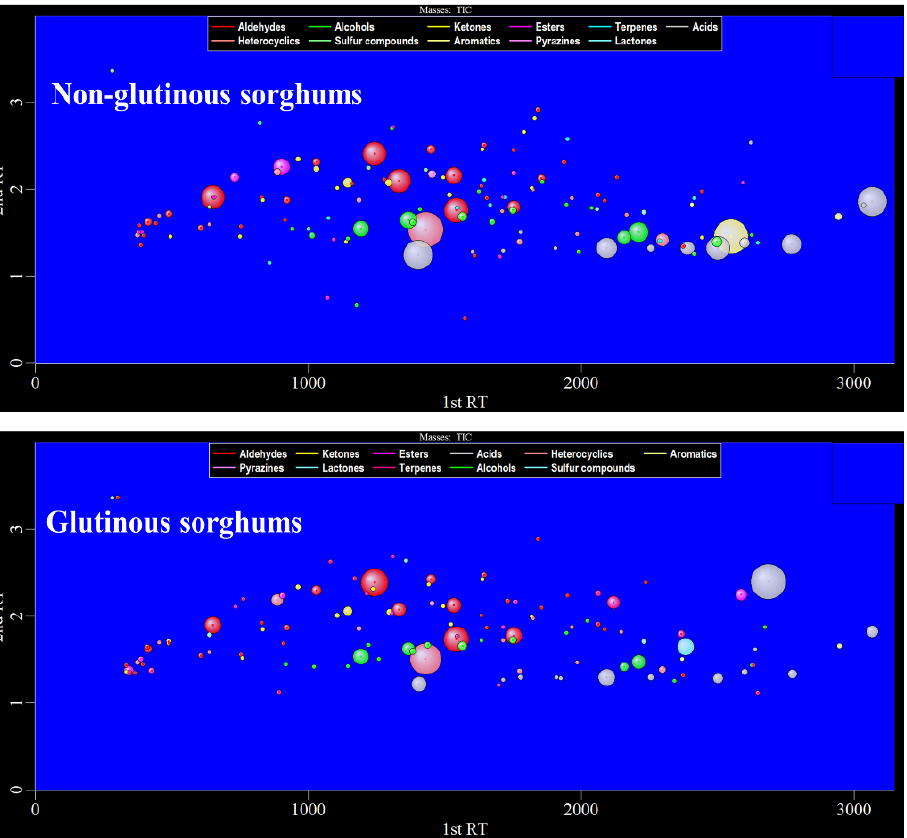
Figure 2. The 2D bubble plot of glutinous and non-glutinous sorghum samples.